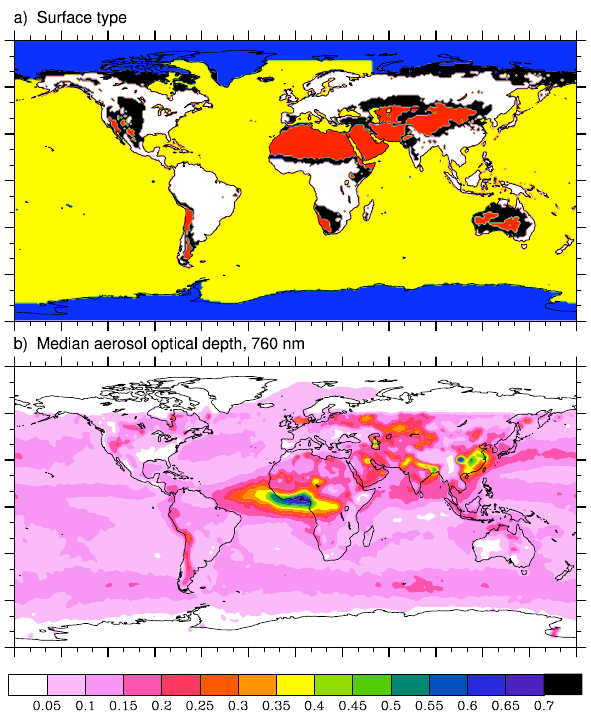
Fig. 4. (a) The five surface cover types assumed: desert (red), conifer (white), ocean/water (yellow), snow (blue), and soil/sparse vegetation (black). (b) The median aerosol OD at 760nm com- puted from Aqua/MODIS data according to the procedure outlined in B¨osch et al. (annual mean of four seasonal medians).